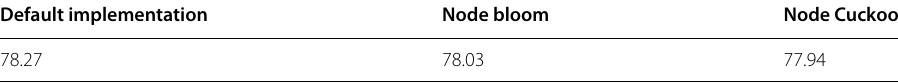
Table 10 Experimental Results 2: insertion performance. Query execution time in